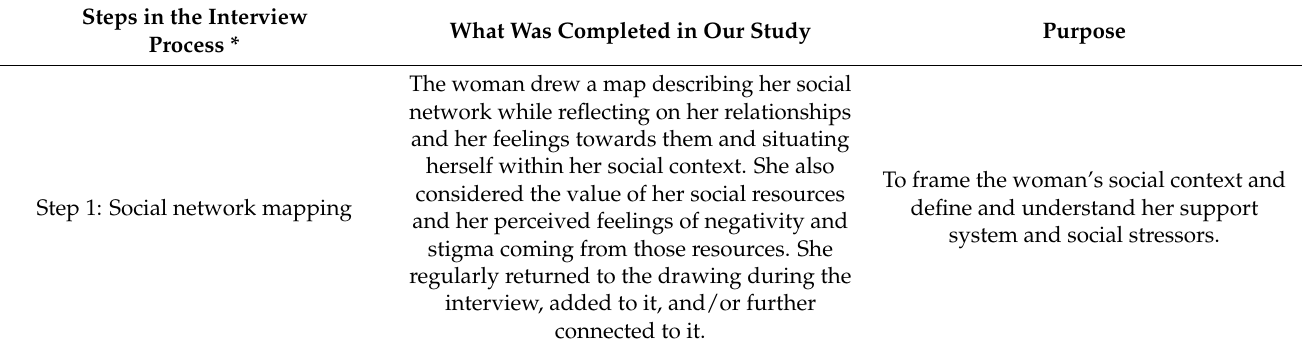
Table 2. The basic steps of the CENI interview and the purpose of each step as followed in the present